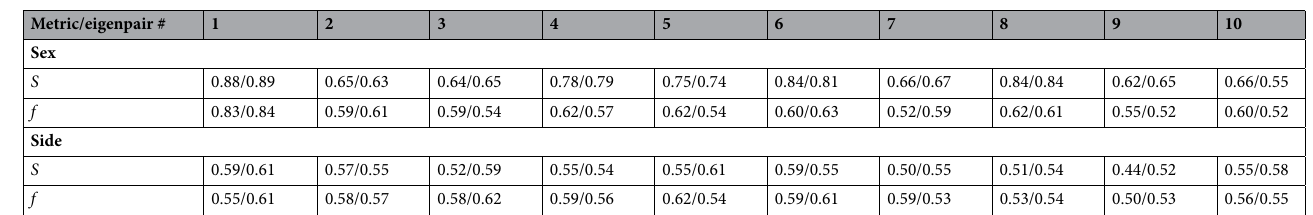
Table 2. Sex and side classification accuracy ACU/AUC of different metrics for model FEMP-II. The CI95% are not shown due to readability, but generally are in range